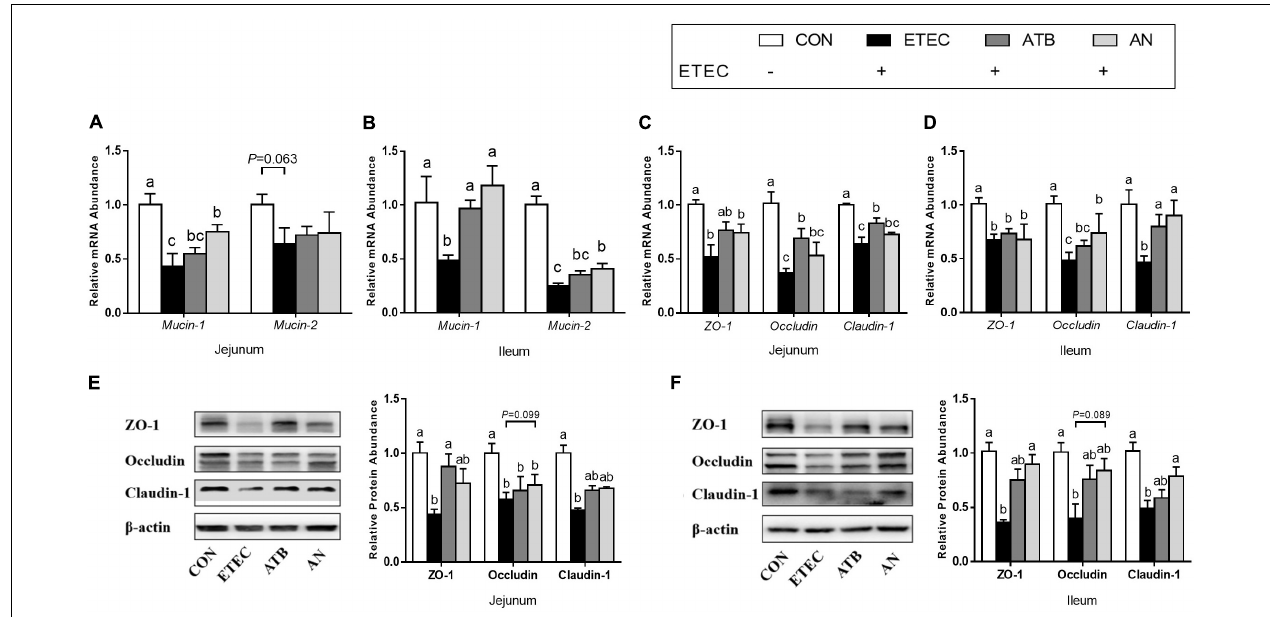
FIGURE 2 | Effects of anethole on (A–B) intestinal secretory and (C–F) barrier function of piglets challenged with enterotoxigenic Escherichia coli K88. For PCR assays, n = 8, GAPDH as reference gene; For western blot, n = 3, β -actin as reference protein; The data in each group is expressed as the mean ± SE. Different letters mean statistically significant difference among the groups ( P <